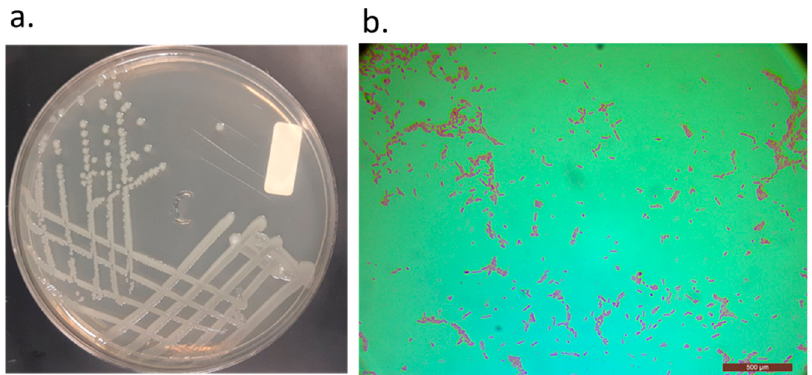
Figure 1. Pure colonies of the MDK33 strain from deteriorated apple fruit ( a ) and Gram staining of MDK33 cells ( b ). Note red rods indicating Gram-negative cells. Magnification was 100×; bar = 500 μ m.